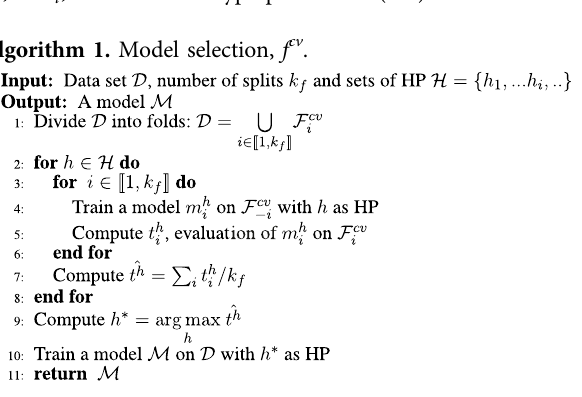
Algorithm 1. Model selection, f cv .